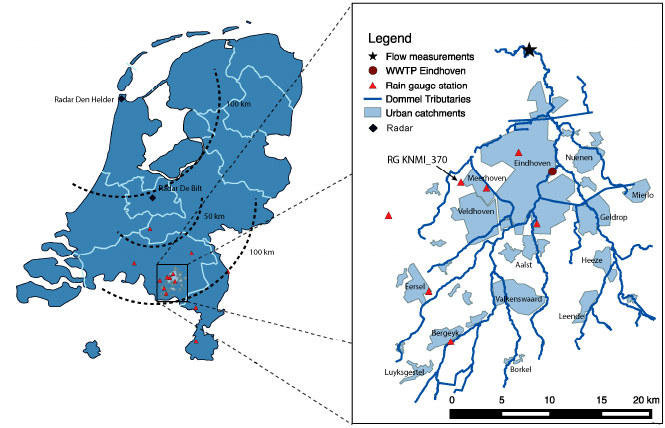
Figure 1. The Dommel water system and the distribution of the main urban contributing areas. Location of rain gauges, C-Band radar stations and river monitoring stations.